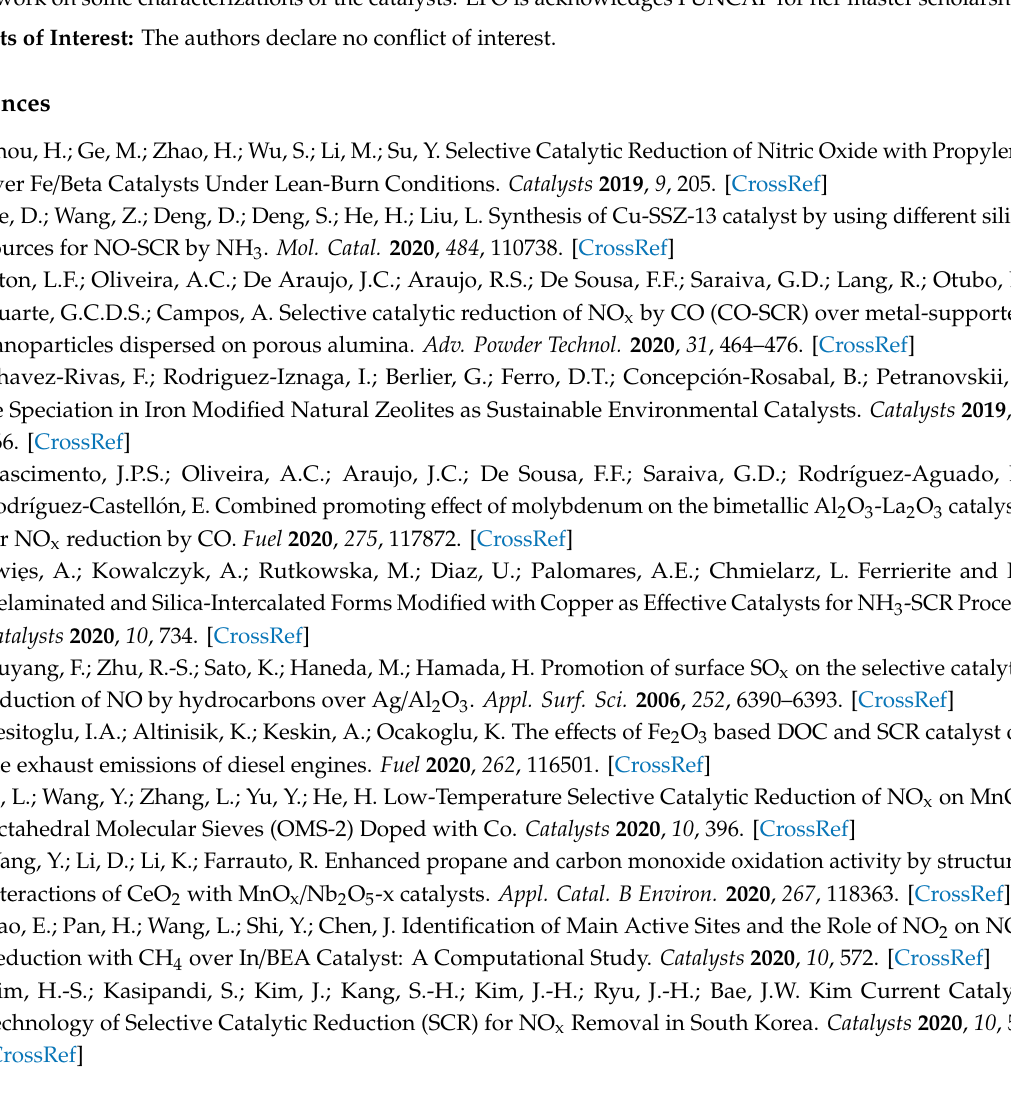
Table S1: Raman modes vibrations and their corresponding